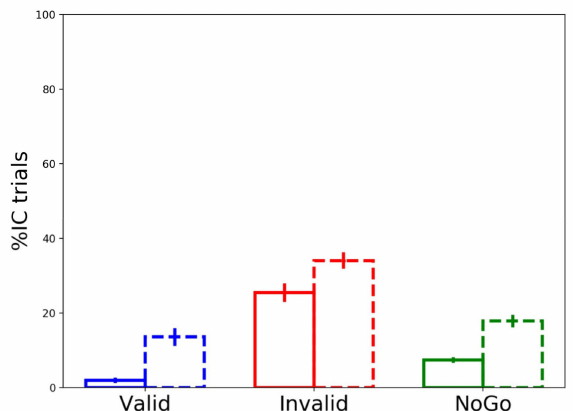
Figure 5. The percentage of partial errors committed following valid (blue bars), invalid (red bars), and NoGo (green bars) cues is displayed separately for compatible (filled lines) and incompatible (dashed lines) trials. Error bars represent the standard